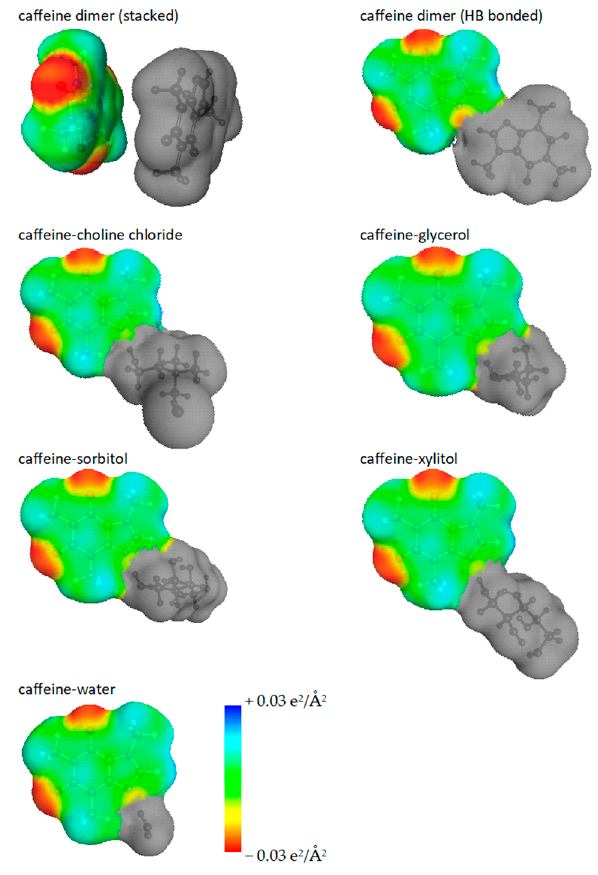
Figure 8. The graphical representation of direct caffeine contacts in ccNADES in the form of “ mcos ” files used for extension of the pool of caffeine conformers in COSMO-RS-DARE computations. The gray part corresponds to forcing the zero-charge setting on all atoms not belonging to caffeine for preserving the formal total charge and atom numbers as monomeric caffeine. Table 1. The values of intermolecular interactions (in kcal/mol) of caffeine in ccNADES systems.